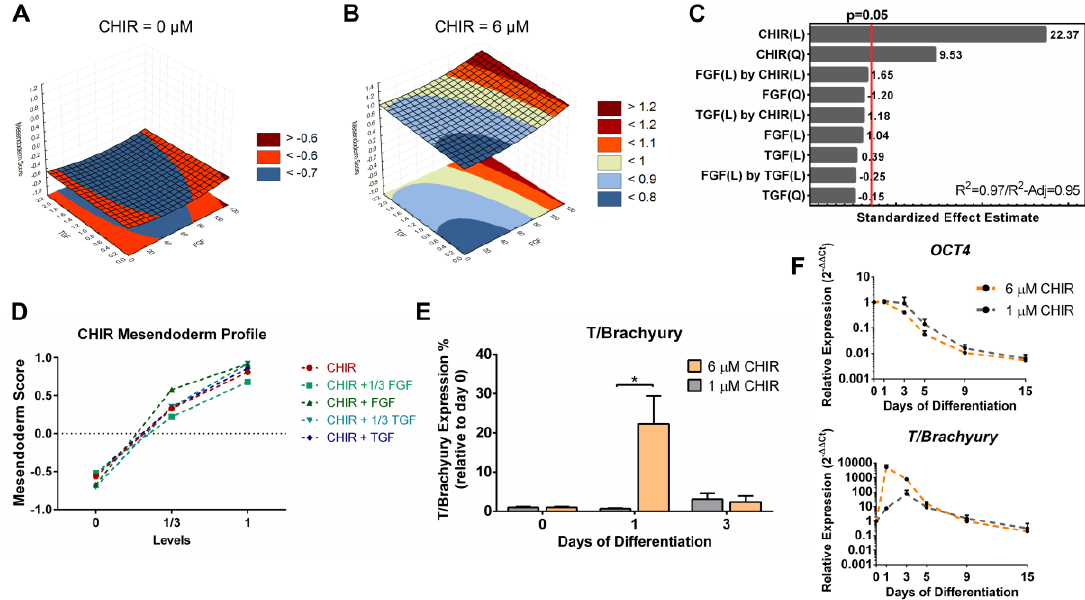
Figure 5. Quadratic model for the mesendoderm scores highlighted a strong positive contribution of Wnt signaling. ( A , B ) Representative curves of TGFβ and FGF2 contributions to the mesendoderm model with CHIR set to zero ( A ) and to 6 µM ( B ). ( C ) CHIR linear and quadratic terms of the model significantly contributed to the mesendoderm model. The model showed a very good fit to the data set, with a R 2 of 0.97 and a R 2 -Adjusted of 0.95. ( D ) Mesendoderm score profile of CHIR supplemented conditions shows an increase with CHIR concentration. ( E ) Flow cytometry of T/Brachyury showed that expression is significantly higher when 6 µM of CHIR is used compared to a lower activation level (1 µM). Error bars, SEM, n = 3. * p -value < 0.05 (two-sided t -test). ( F ) Real-time PCR comparison of OCT4 and T/Brachyury for cardiac differentiation using 6 µM or 1 µM of CHIR showed a similar decreasing profile of OCT4 gene expression, while 6 µM of CHIR contributed to a significantly higher gene expression of T/Brachyury at day 1. Error bars, SEM, n = 3. See Figure S4 and Table S4 for mesendoderm full model information.